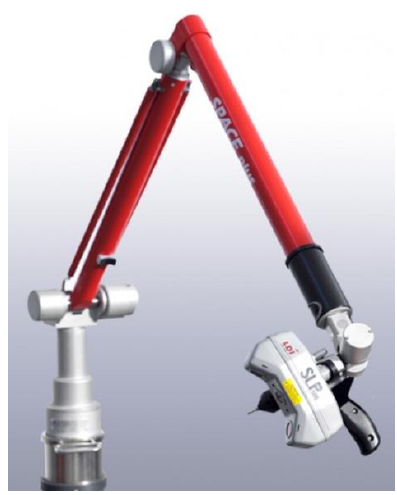
Figure 1. Precision laser probe 3D scanning.